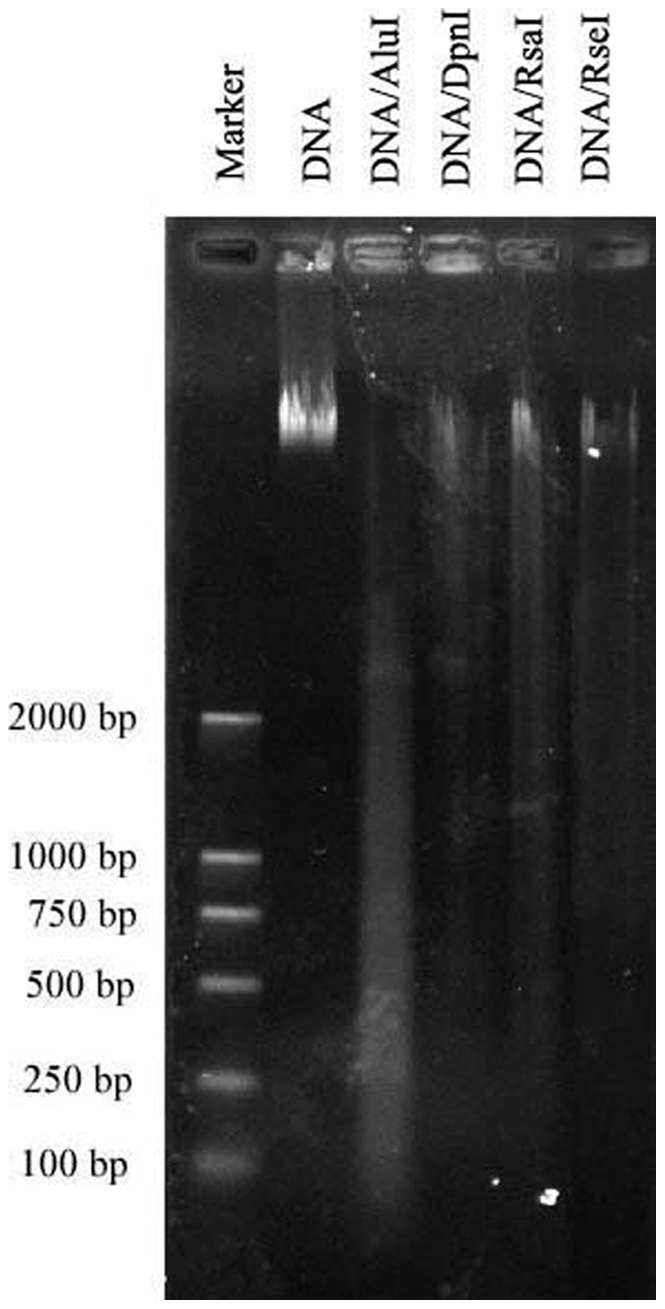
Gel image of digested rapeseed DNA.Rapeseed DNA was digested with fourblunt end enzymes, AluI, DpnI, RsaI and RseI, respectively.